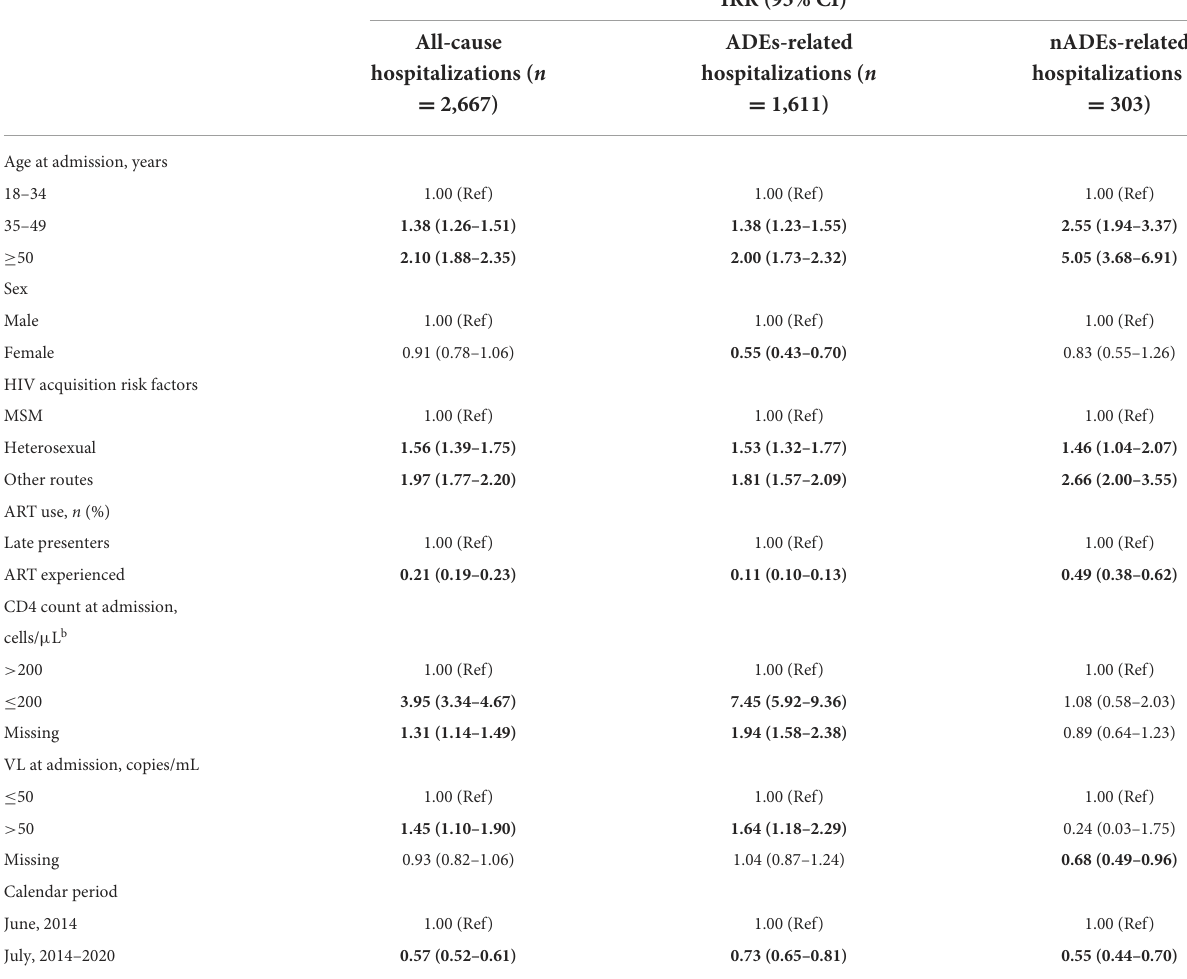
TABLE 4 Multivariable analyzes of factors associated with hospitalization for all causes, ADEs, and